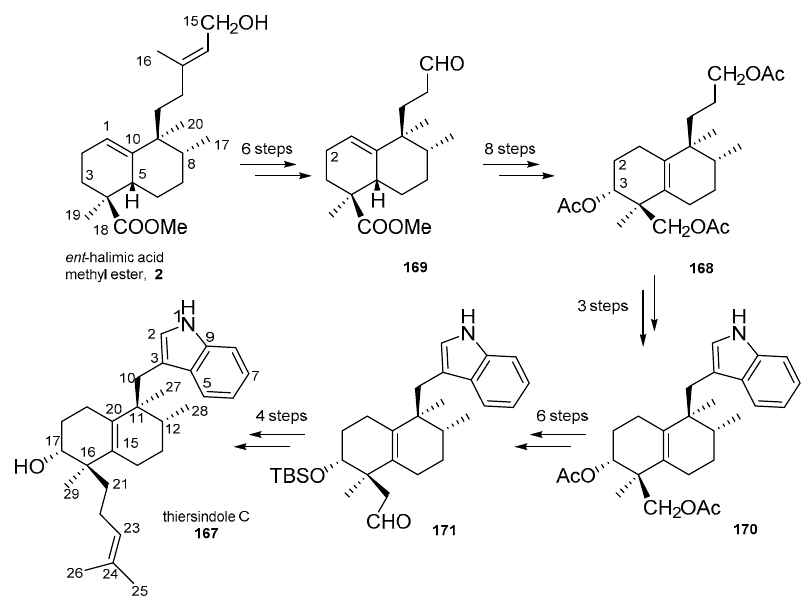
Scheme 12. Synthesis of (+)-thiersindole C from 2.